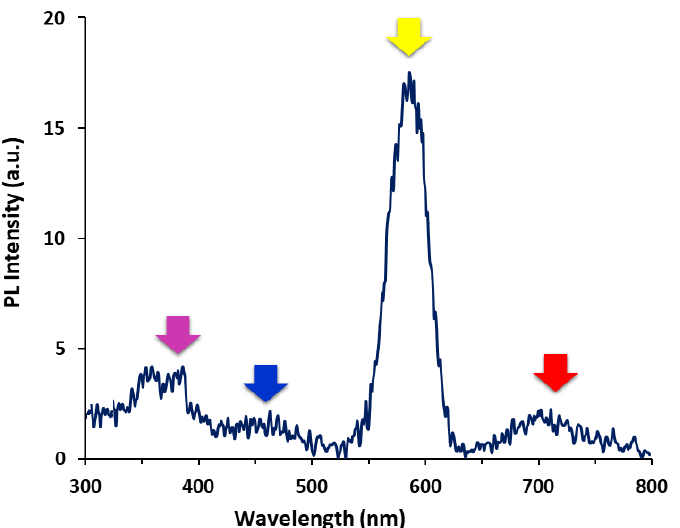
Fig. 4. FT-IR spectrum of Bi Figure 4. FT-IR spectrum of Bi 2 WO 6 sample